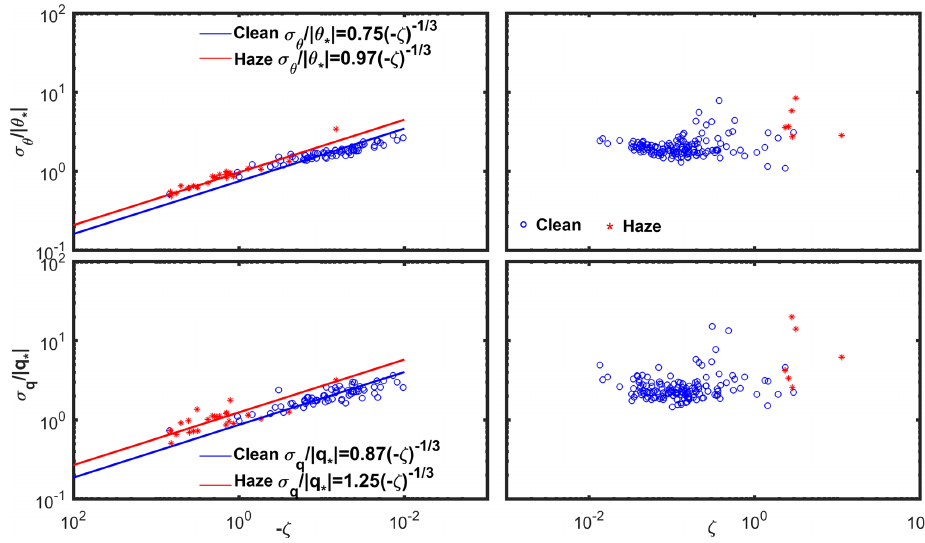
Figure 10. Normalized standard deviations in the potential temperature ( σ θ / | θ ∗ | ) and moisture content ( σ q / | q ∗ | ) as functions of the stability parameter ζ . The red (blue) line in the figure represents the results under polluted (clear) weather conditions. Observations marked with ∗ ( ◦ ) were made under polluted (clear) weather